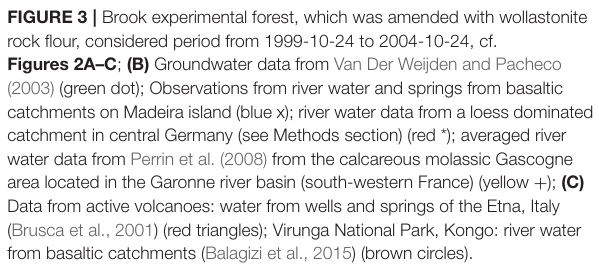
FIGURE 3 | Brook experimental forest, which was amended with wollastonite rock flour, considered period from 1999-10-24 to 2004-10-24, cf. Figures 2A–C ; (B) Groundwater data from Van Der Weijden and Pacheco (2003) (green dot); Observations from river water and springs from